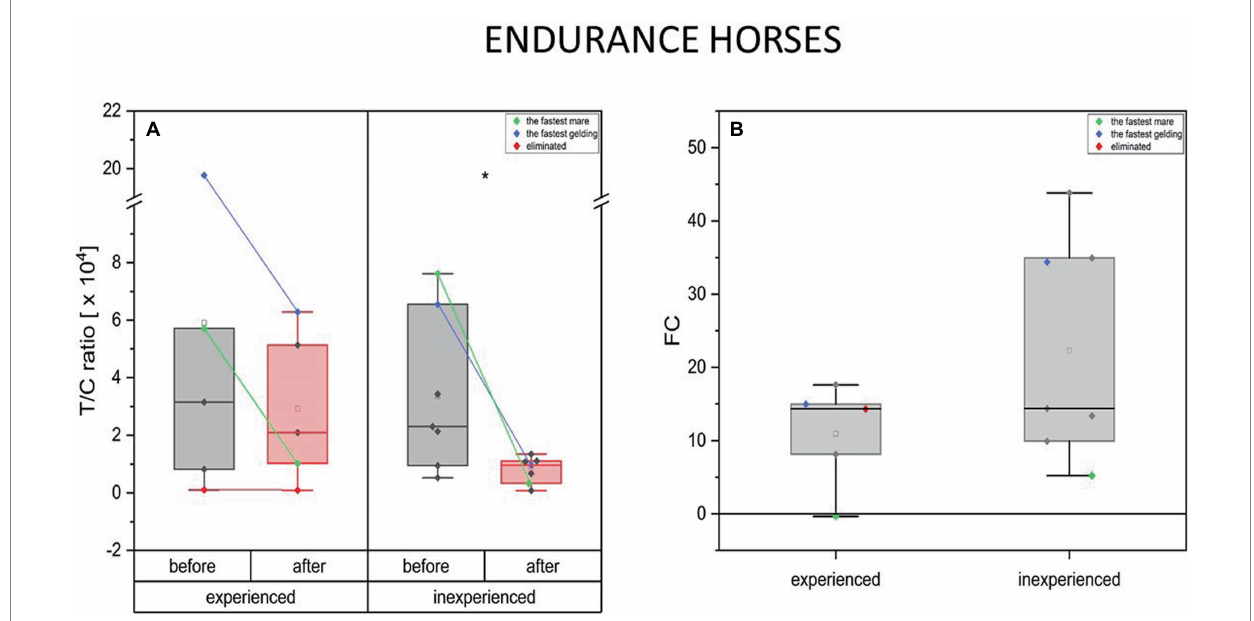
FIGURE 6 Changes in the anabolic index (T/C ratio) upon training in experienced ( n = 5) and inexperienced ( n = 7) endurance horses. Colored data points indicate the fastest mare (green), the fastest gelding (blue), and the eliminated gelding (red). Box plots (IQR, mean and median; whisker range within 1,5IQR) are expressed as differences in molar plasma concentration (A) and fold change (FC) (B) . Statistically significant differences are indicated by asterisks at p < 0.05 (*), p < 0.01 (**), and p < 0.001